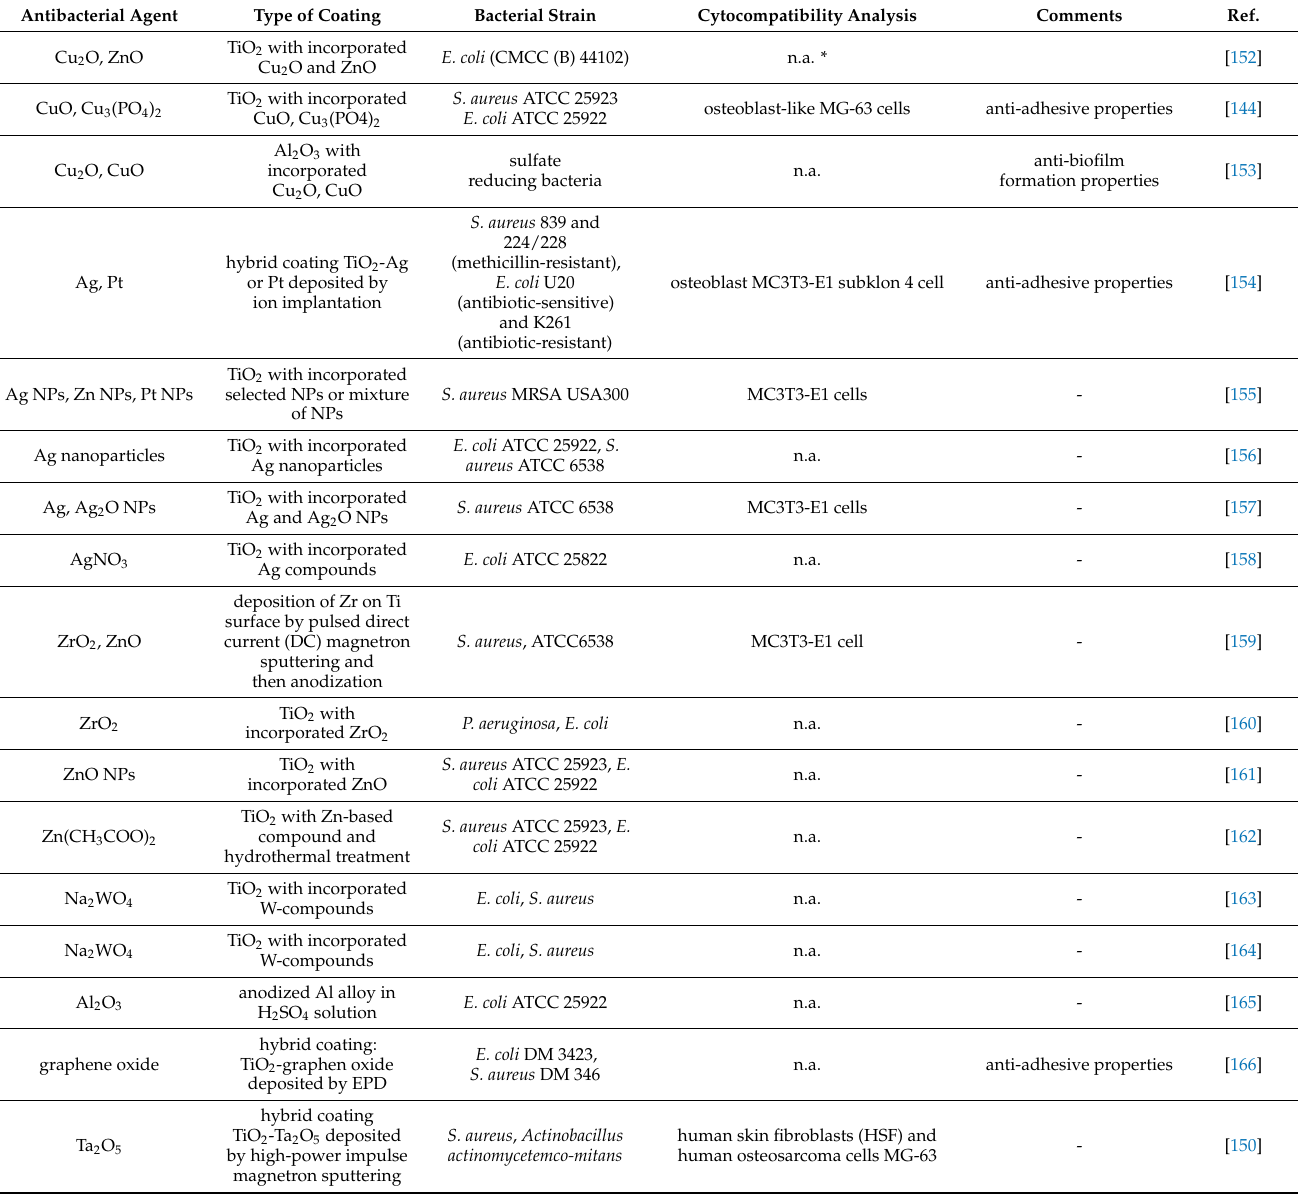
Table 1. Antimicrobial effects of various porous oxide layer coatings formed via plasma electrolytic oxidation on metal surfaces or the effect of hybrid coatings on microbial activity when the base layer is formed by anodization. The cytocompatibility of the coatings is evaluated to determine the balance between the cytotoxicity of various bacteria and the acceptable cytocompatibility of treated